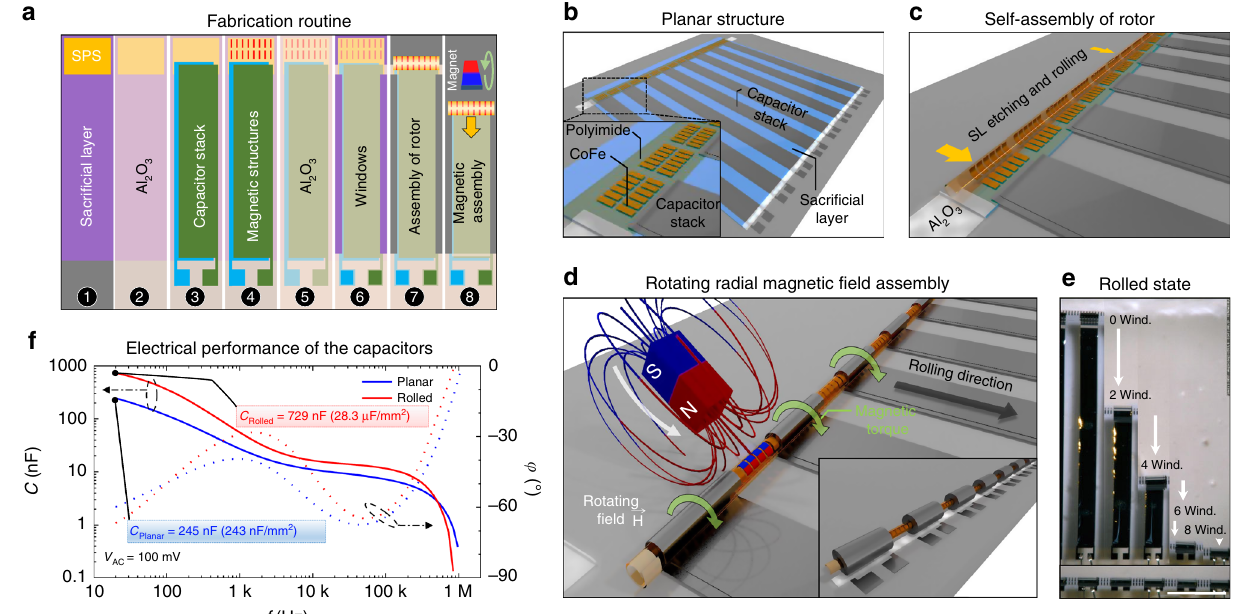
Fig. 6 Fabrication of capacitors using the radial dynamic magnetic fi eld assembly. a Fabrication routine for the radial magnetic fi eld assembling approach. b Planar polymeric and capacitor stack. c Magnetic rotor self-assembly during which the sacri fi cial layer dissolves and the hydrogel layer swells. d Assembly of capacitors in an external rotating magnetic fi eld by winding the unstrained capacitor nanomembrane stack onto the magnetic rotor. (Inset) Assembled capacitors after fabrication. e Time sequence of winding process. Bottom image shows assembled array of capacitors. Scale bar is 1 mm. f Electric performance of planar and assembled capacitors 5 and 10 mm in length measured in H 2 SO 4